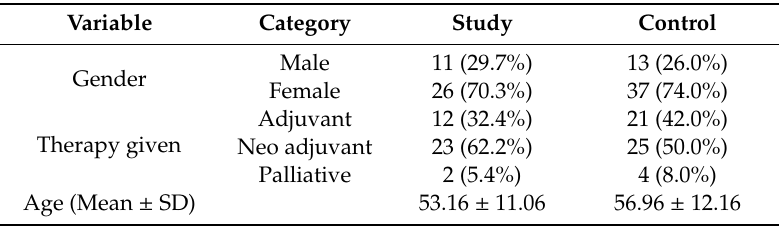
Table 1. Baseline characteristics of participants.